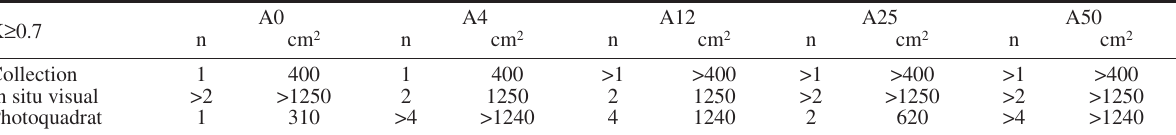
Table 2. – Number of samples (n) and sampling area (cm 2 ) to obtain a Kulczynski Index of K ≥ 0.7 for each method and depth. The season with the lowest similarity value was used as a reference. K ≥ 0.7